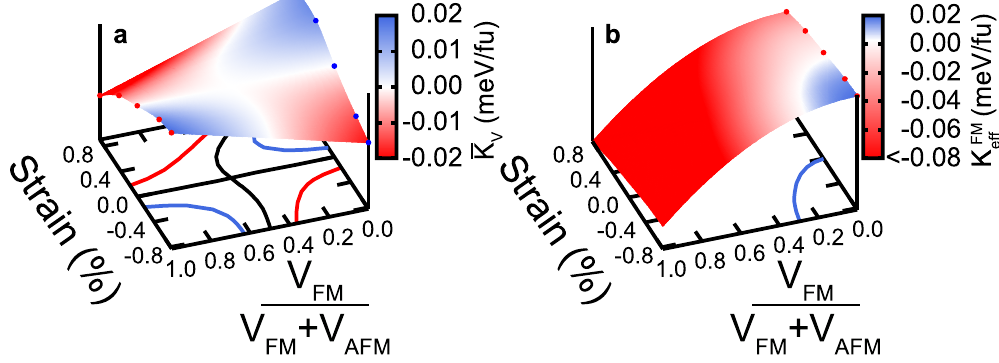
Figure 2. Ab-initio calculations results of the FeRh magnetic anisotropy as a function of strain. ( a ) The volume- averaged magnetic anisotropy energy, K , as a function of strain and FM/AFM volume fraction. ( b ) The net V magnetic anisotropy energy of the FM phase is shown, including demagnetization effects.